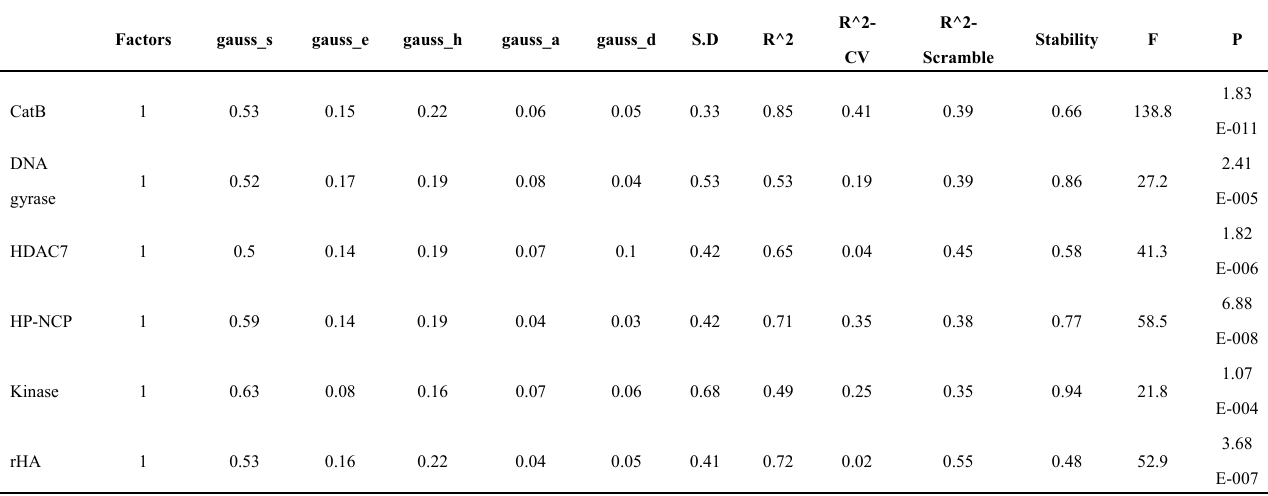
Table 7. The statistical results of the QSAR analysis called COMSIA of the Glide docked result. Factors